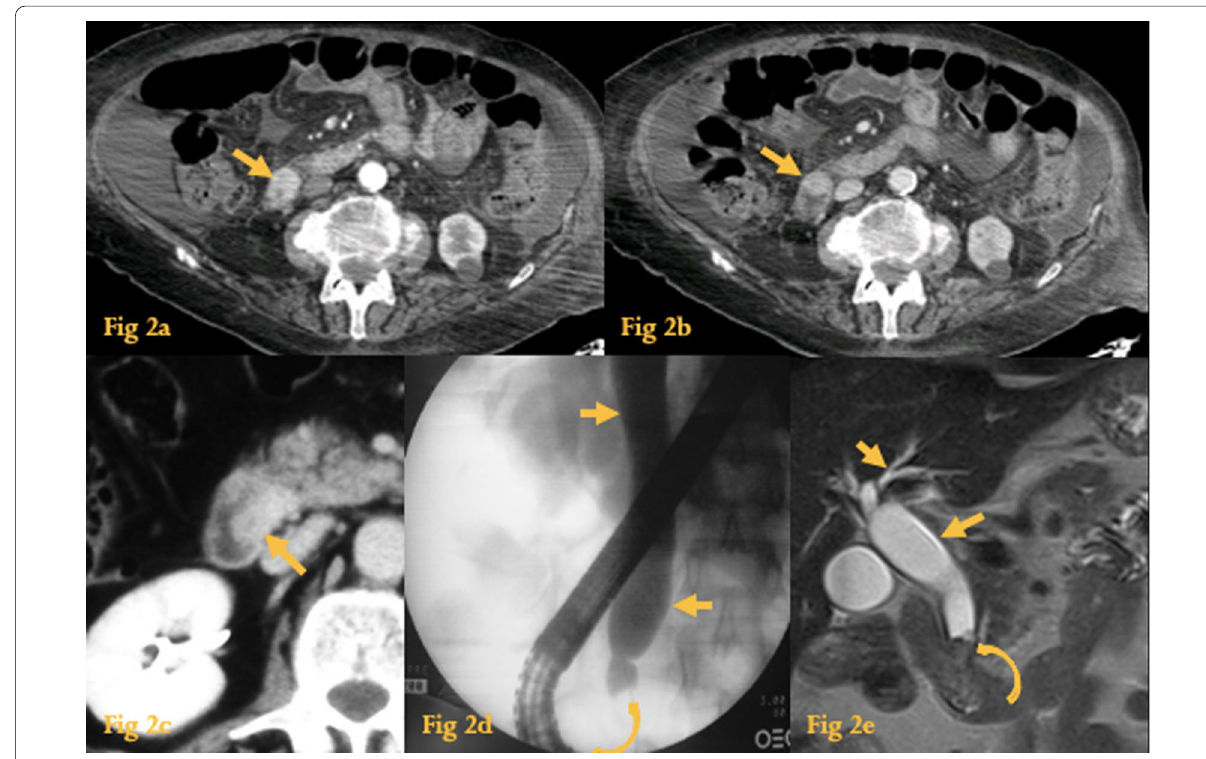
Fig. 2 Ampullary tumors. Contrast‑enhanced CT ( a , b ) reveals an enhancing soft‑tissue mass (arrows), originating in the medial wall of the descending duodenum. This was a case of an ampullary adenocarcinoma. Contrast‑enhanced CT of another patient with an ampullary carcinoma ( c ), shows a soft‑tissue mass (arrow) originating in the medial wall of the descending duodenum and protruding into the water‑filled duodenum. ERCP ( d ) revealed an enlarged and irregular suspicious papilla (curved arrow) and CBD dilatation (arrows). MRCP ( e ) of another patient shows dilatation of the CBD and intra‑hepatic ducts (arrows) due to an abrupt stop at the distal CBD (curved arrow), which was caused by an ampullary villous